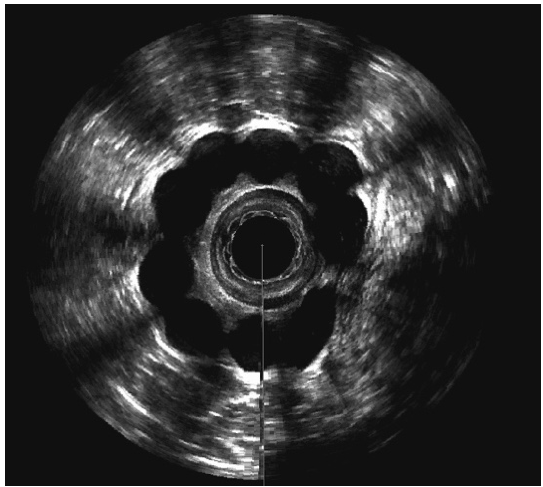
Figure 4. 3D-endoanal ultrasound image of a patient at follow-up with nine Sphinkeeper prostheses. Nearly all patients (91%) showed a migration of at least one prosthesis. In ten patients, six (60%) prostheses were found at the same level. We categorized the position of the prosthesis in relation to the anal canal axis. The median number of prostheses remaining parallel (0 ◦ –45 ◦ ) to the anal canal was six (range 5–9), while in median, two (range 0–4) prostheses showed a shifting grade I ◦ (46 ◦ –90 ◦ ). In median, zero prostheses (range 0–1) reached shifting grade II ◦ (>90 ◦ ) (see Figures 5 and 6).